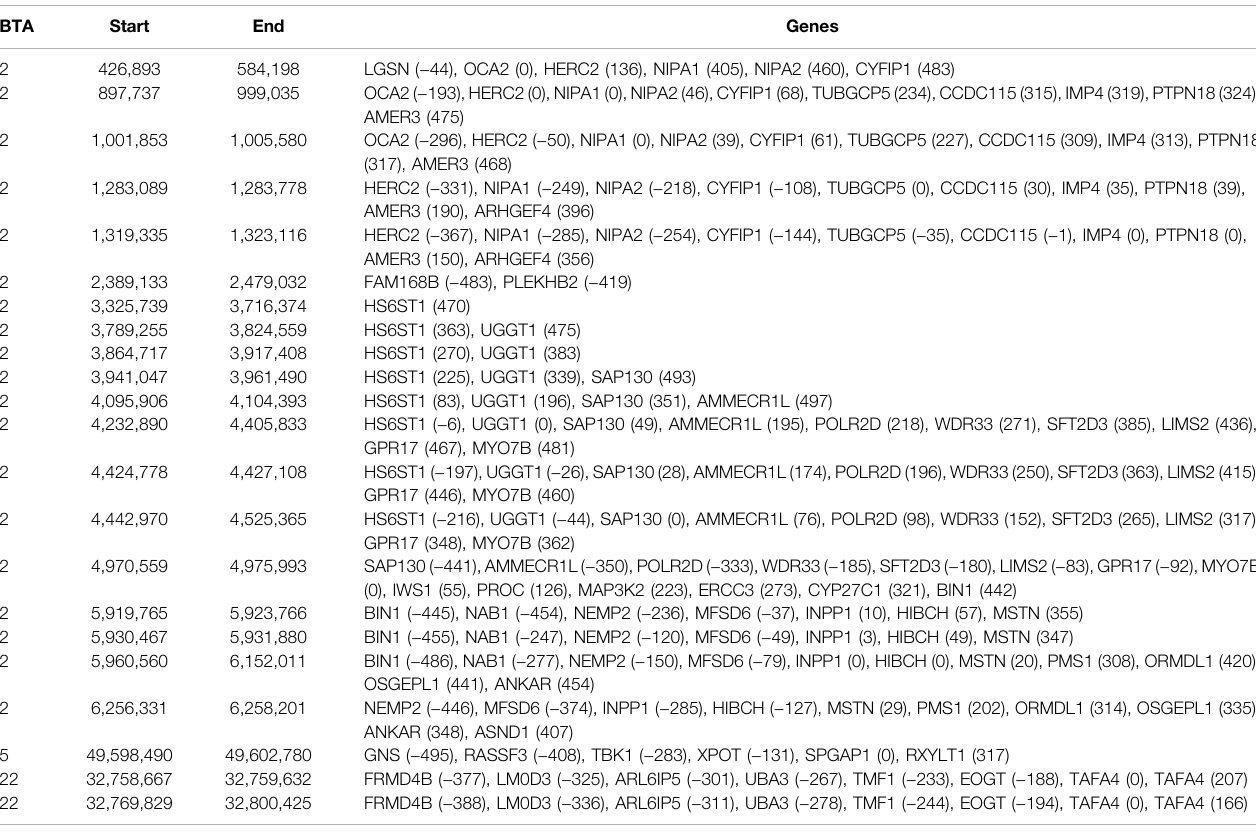
TABLE 6 | Chromosome (BTA) and start and end position (bp) of each imprinted QTL regions de fi ned for carcass fat, as well as the name of genes located within a 0.5 Mb window of each region [distance (in Kb) from the lead SNP of each region in parenthesis] a